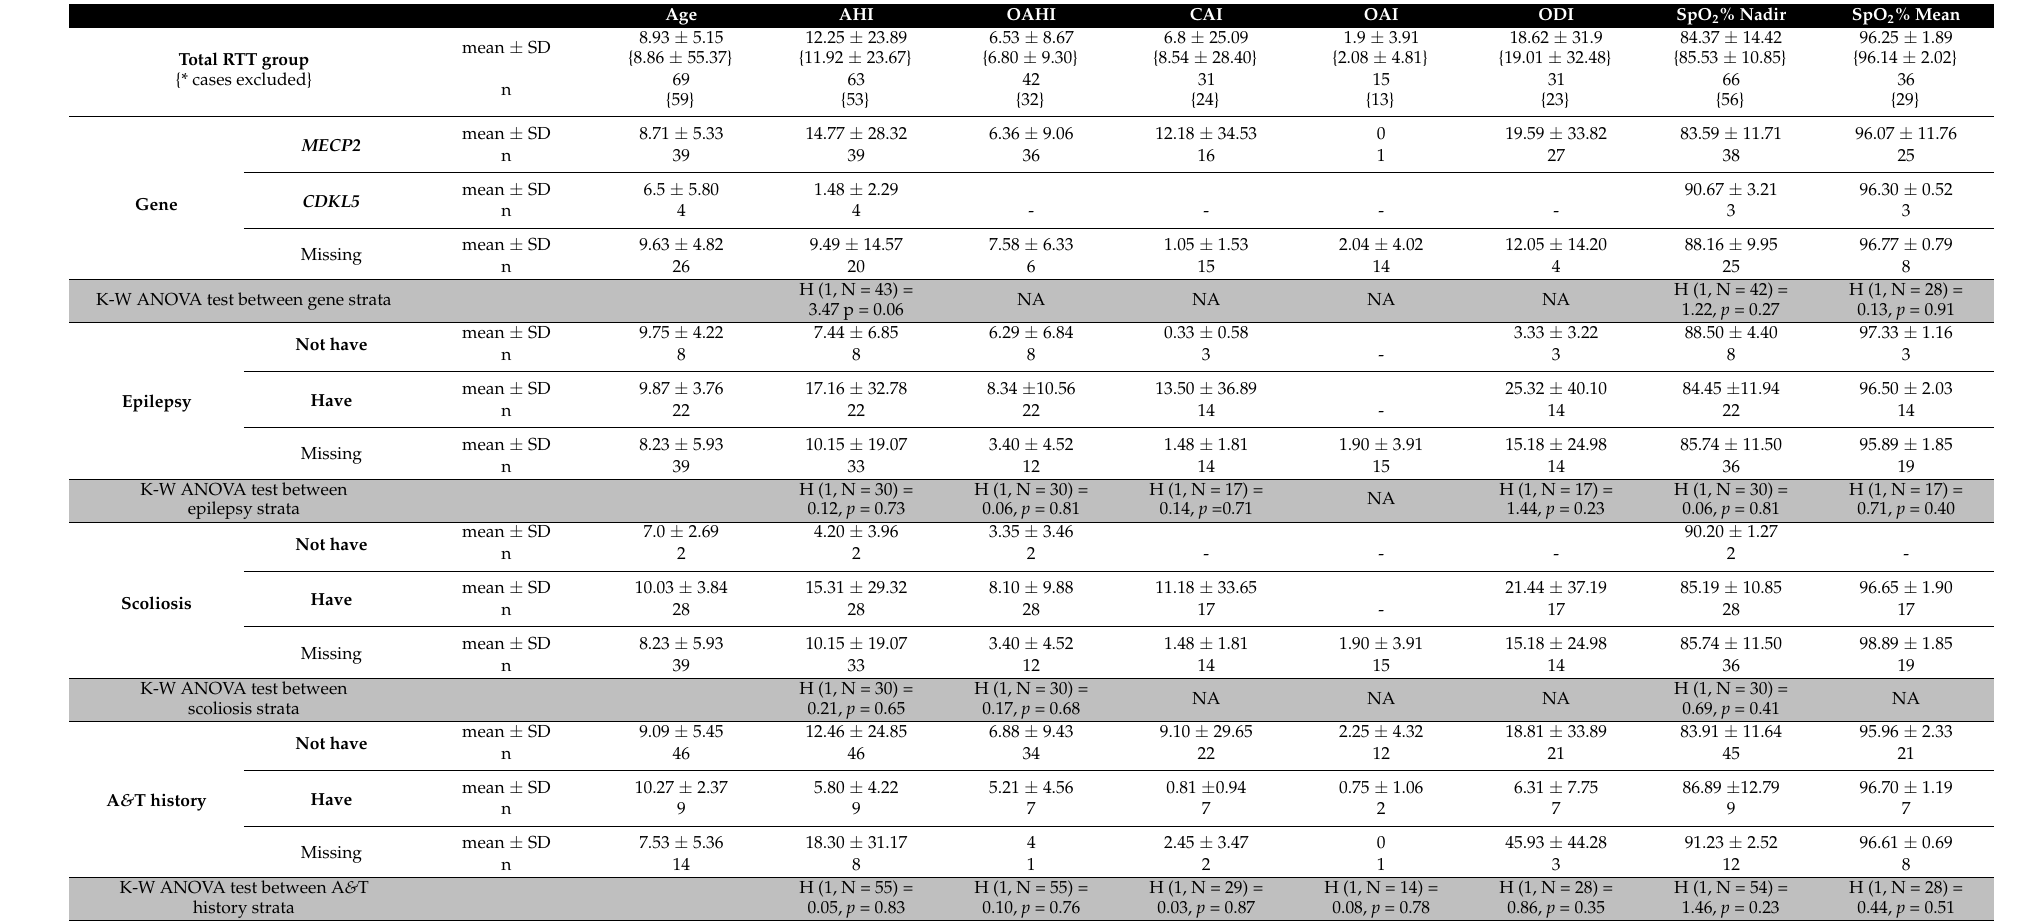
Table 3. Summary of sleep breathing